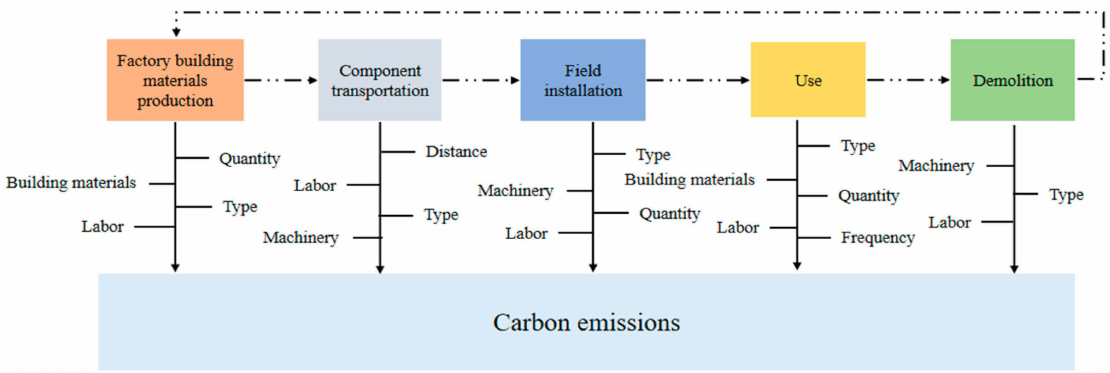
Figure 2. Source and impact of the life cycle carbon